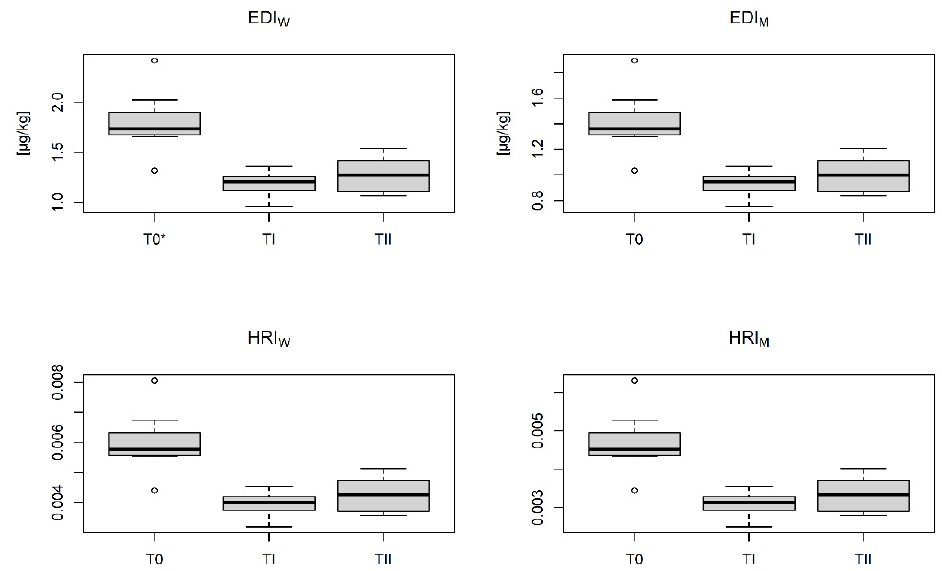
Figure 10. Estimated daily intake (EDI) and health risk index (HRI) calculated for women (W) and men (M) for Zn in oat; * for descriptions see Material and Methods. Statistically significant differ- ences and p -value are presented in Table 3.